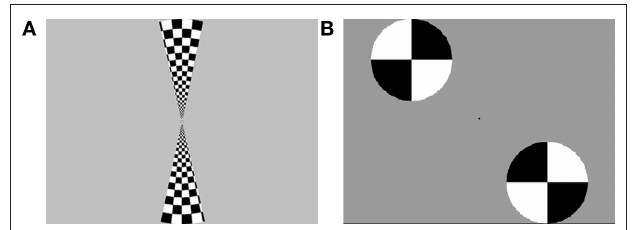
FIguRe 2 | (A) Bowtie stimuli used for retinotopic mapping. (B) Disc stimuli used for functional localization of regions processing the distractor